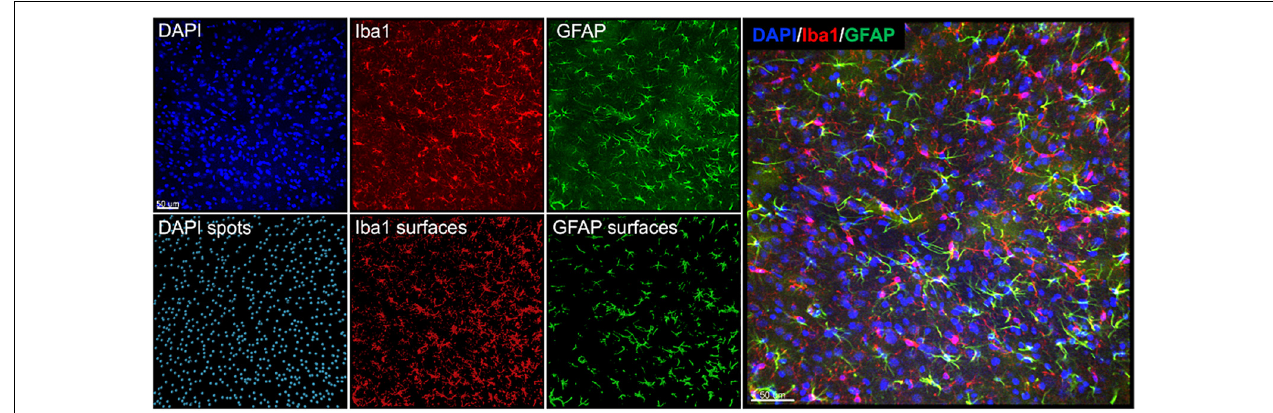
FIGURE 4 | Representative images and Imaris renderings used in analyses. DAPI, Iba1, and GFAP were imaged from the same tissue as described in the section “Materials and Methods.” Spots were rendered from the DAPI channel, and surfaces were rendered from the Iba1 and GFAP channels to measure the total number of cells, number of Iba1 + cells, Iba1 intensity, and GFAP